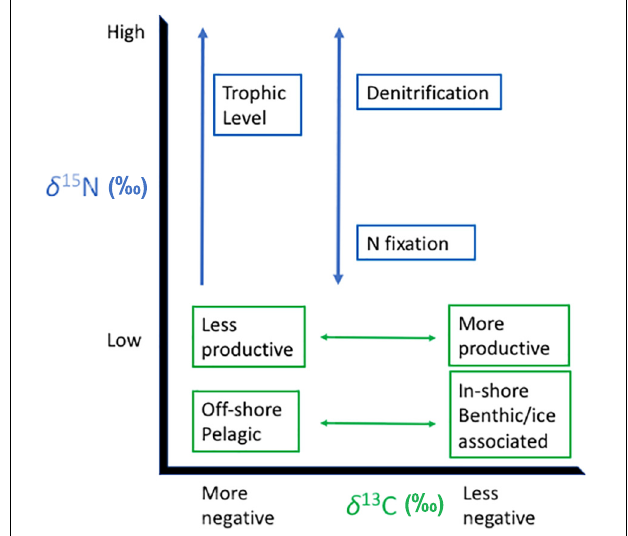
FIGURE 1 | Schematic illustrating potential factors influencing the stable isotope niche space or isospace of marine megafauna in ocean systems. Stable carbon isotope values provide information regarding animal foraging location as these values most often reflect patterns at the base of the food web (Rau et al., 1982; Fry, 2006; Ben-David and Flaherty, 2012). For example, animals foraging offshore usually have lower δ 13 C values than those foraging nearshore. The spectrum of productivity refers to conditions that influence phytoplankton growth rates as higher nutrient inputs result in faster growth rates leading to higher δ 13 C values for all levels of a food web (Bidigare et al., 1997; Popp et al., 1998). Stable nitrogen isotope values inform animal trophic position and reflect nitrogen processes at the base of the food web that drive stable isotope values for all consumers within that system (see overview in Rau et al., 2003; Somes et al., 2010; Allen et al., 2013; Kurle and McWhorter, 2017; Turner Tomaszewicz et al., 2017). Here, we highlight the natural nitrogen cycle influences on the base of the food web which create differences across ecosystems, but anthropogenic nitrogen loading from point and run-off sources on land can also alter nitrogen signatures of primary producers (Costanzo et al., 2001; Lemons et al., 2011). Fractionation between diet and consumer can vary across species for both carbon and nitrogen and is likely due to diet composition, quality, trophic position, and form of nitrogen excretion (Germain et al., 2013; McMahon et al., 2015b,c; Nielsen et al., 2015; Kurle et al.,